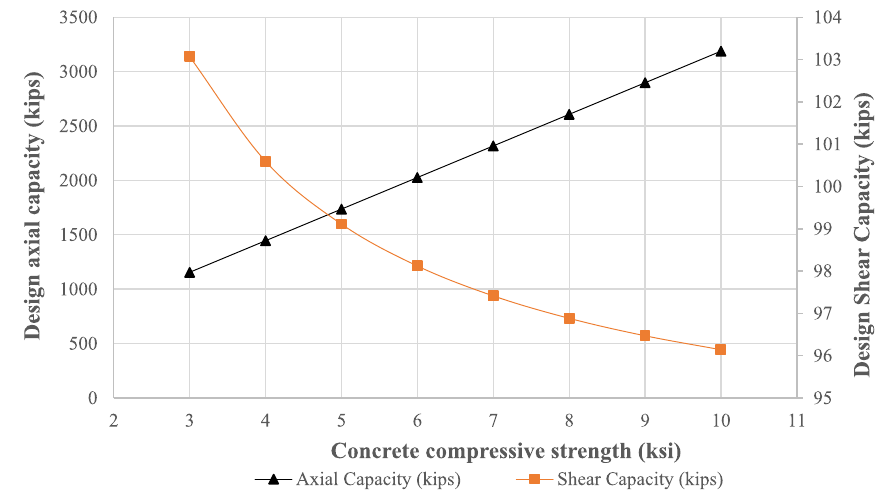
Fig. 3 Concrete compressive strength with design axial and shear capacities of RC